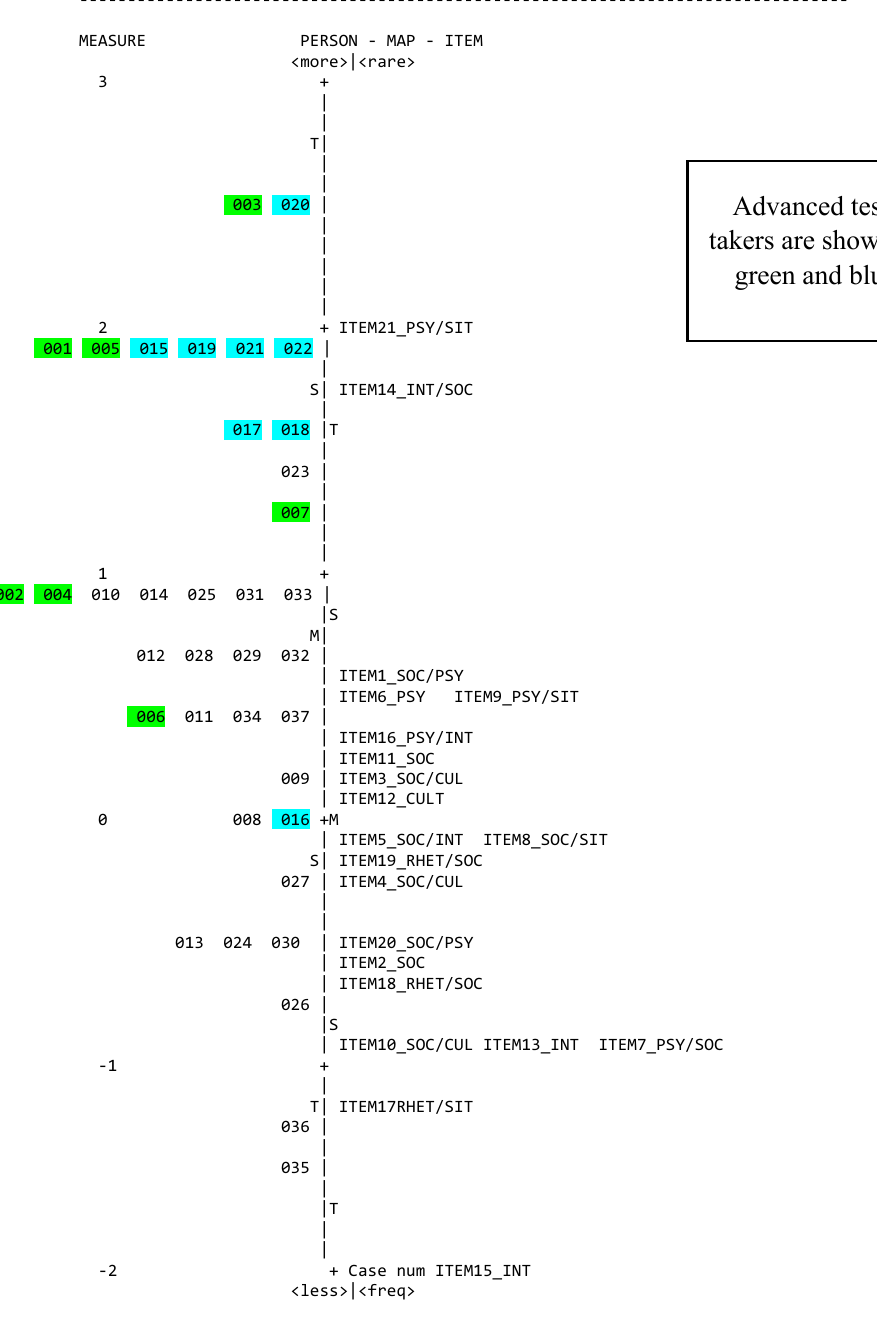
Advanced test- takers are shown in green and